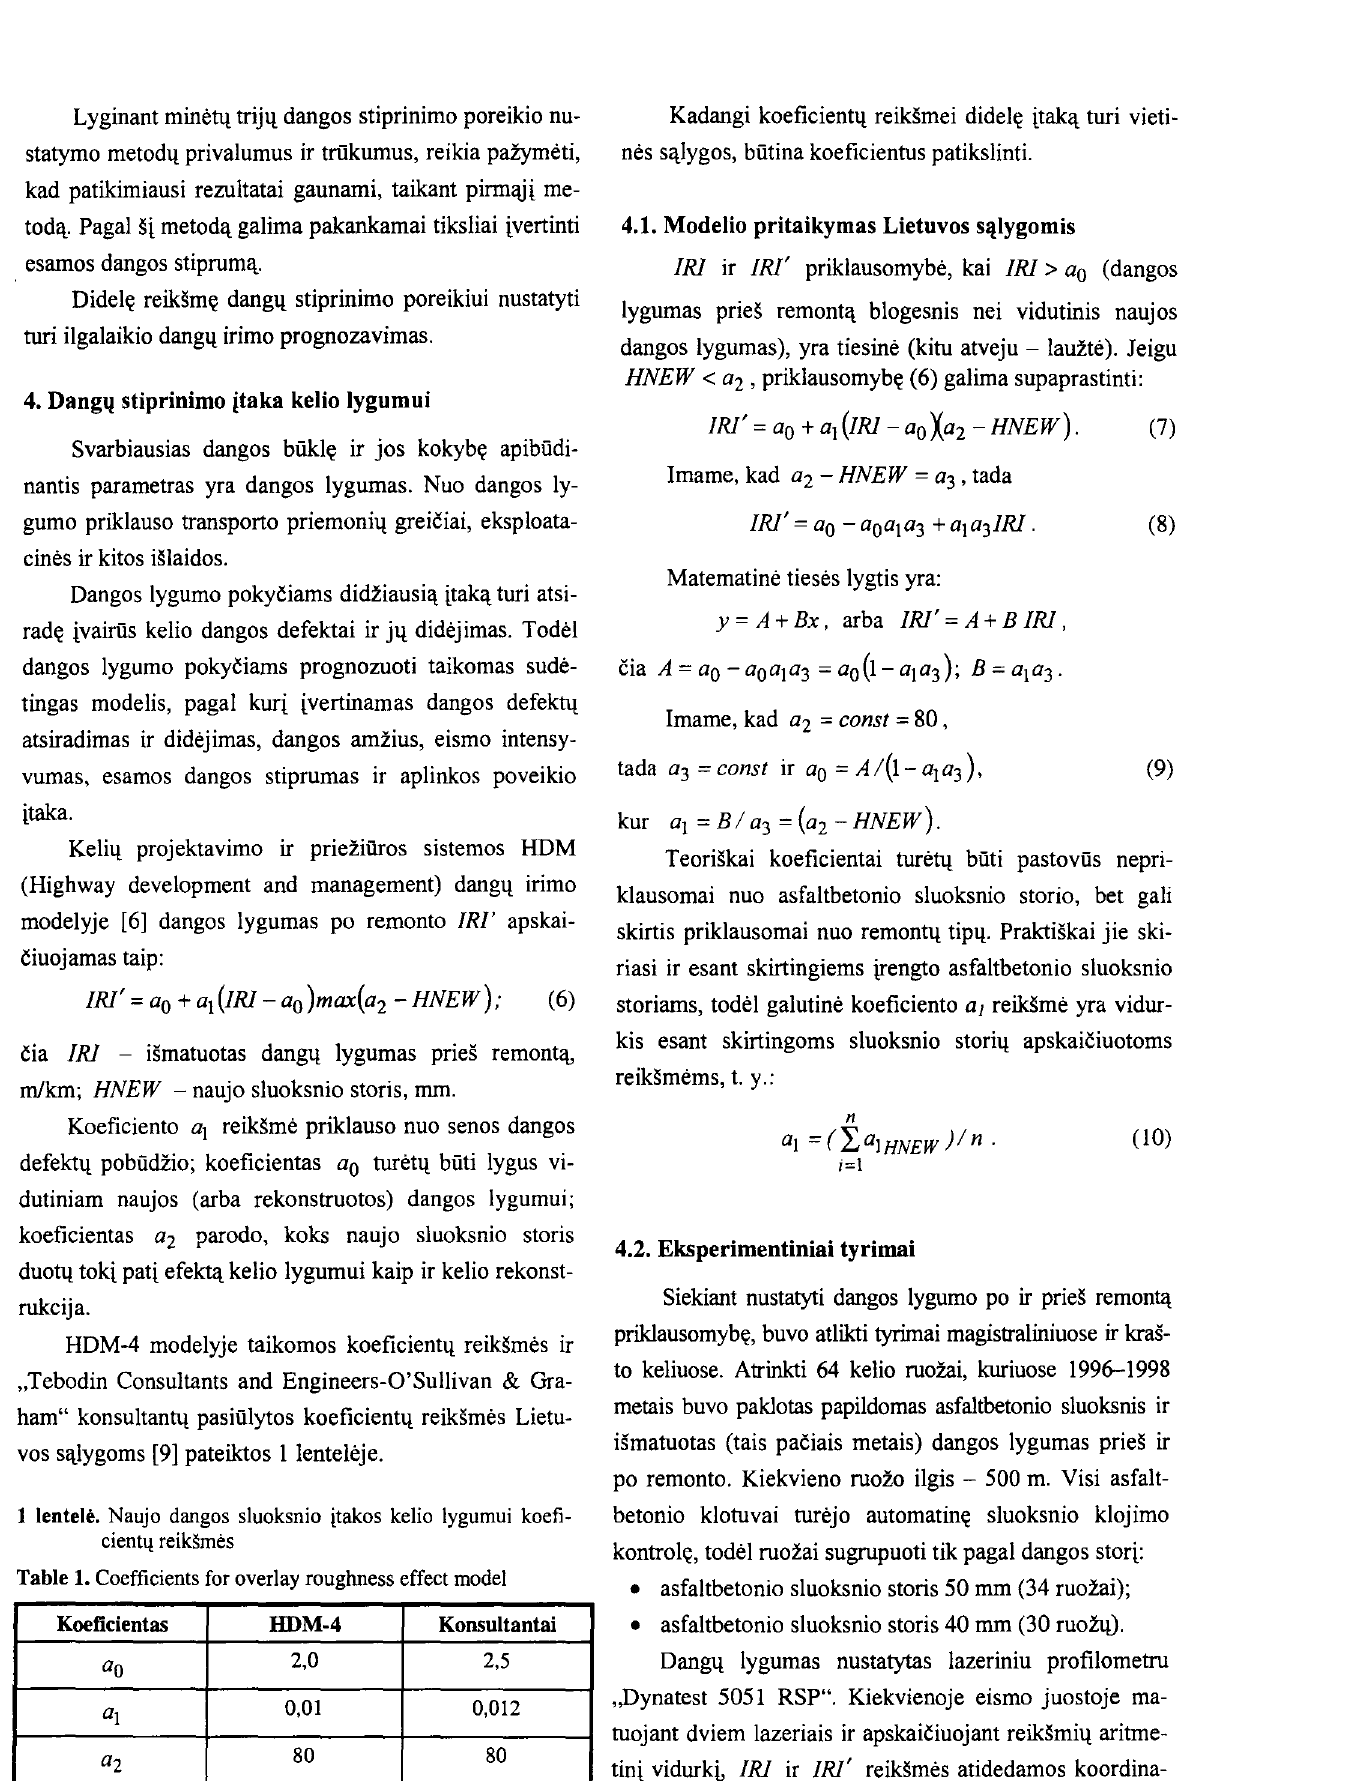
Table 1. Coefficients for overlay roughness effect